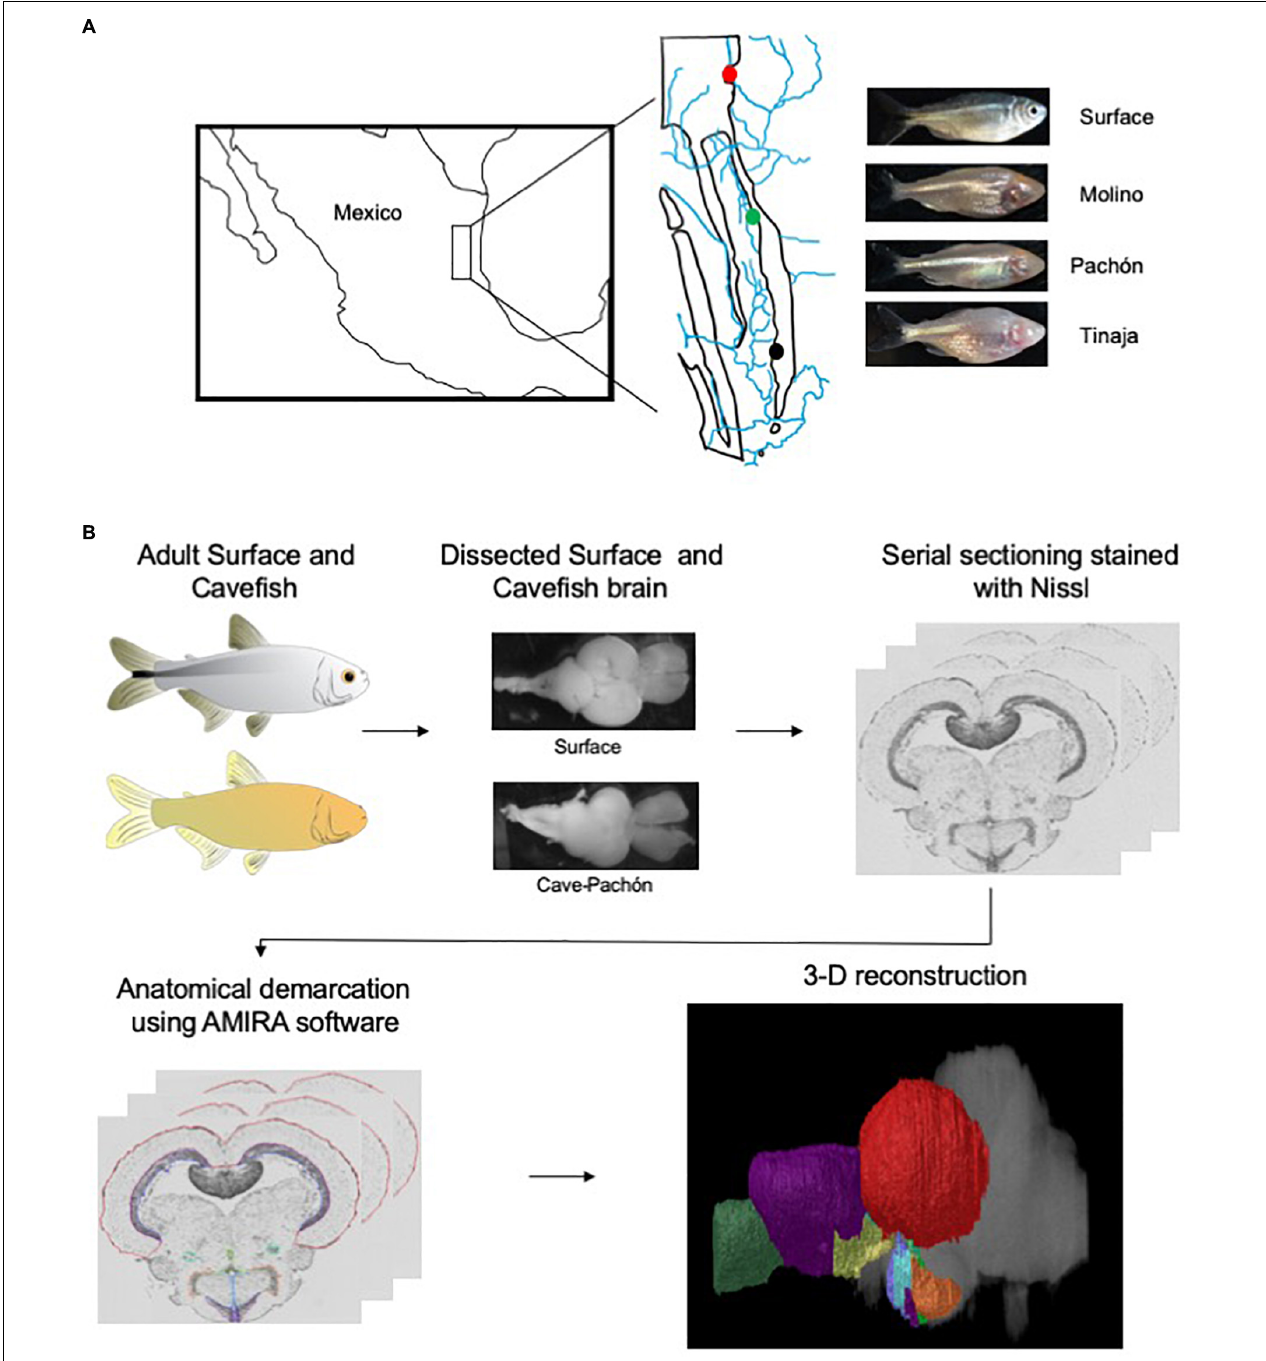
FIGURE 1 | Overview of experimental design. (A) Map of Mexico with location of Molino (red), Pachón (green) and Tinaja (black) caves. (B) Flow chart diagraming experimental design and procedure.